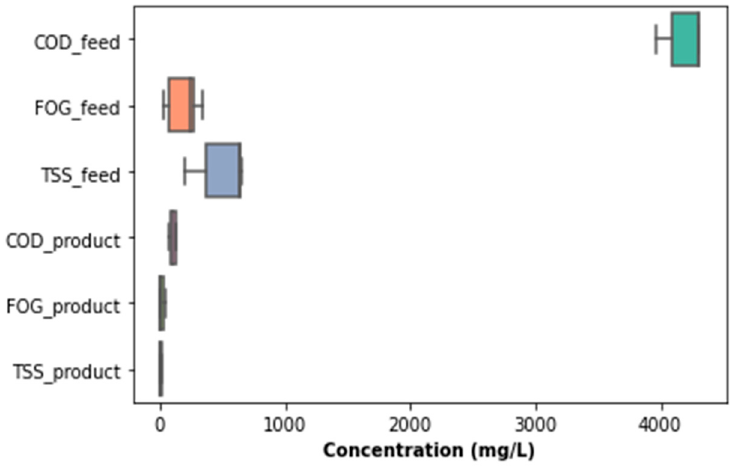
Figure 20. Boxplots of the parameters for the overall process.